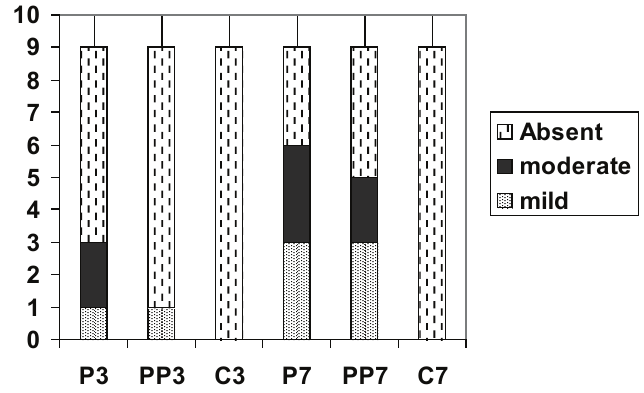
FIGURE 2 - Frequency of hydropic degeneration in the animals of the 3 groups (P, PP and C) at both time points (3 and 7 days) - subgroups P3, P7, PP3, PP7, C3, C7): P Group - pneumoperitoneum for 30 minutes before laparotomy (P3, P7); PP Group– pneumoperitoneum for 30 minutes before laparotomy and 30 minutes after suture (PP3, PP7); C Group - control without pneumoperitoneum (C3,